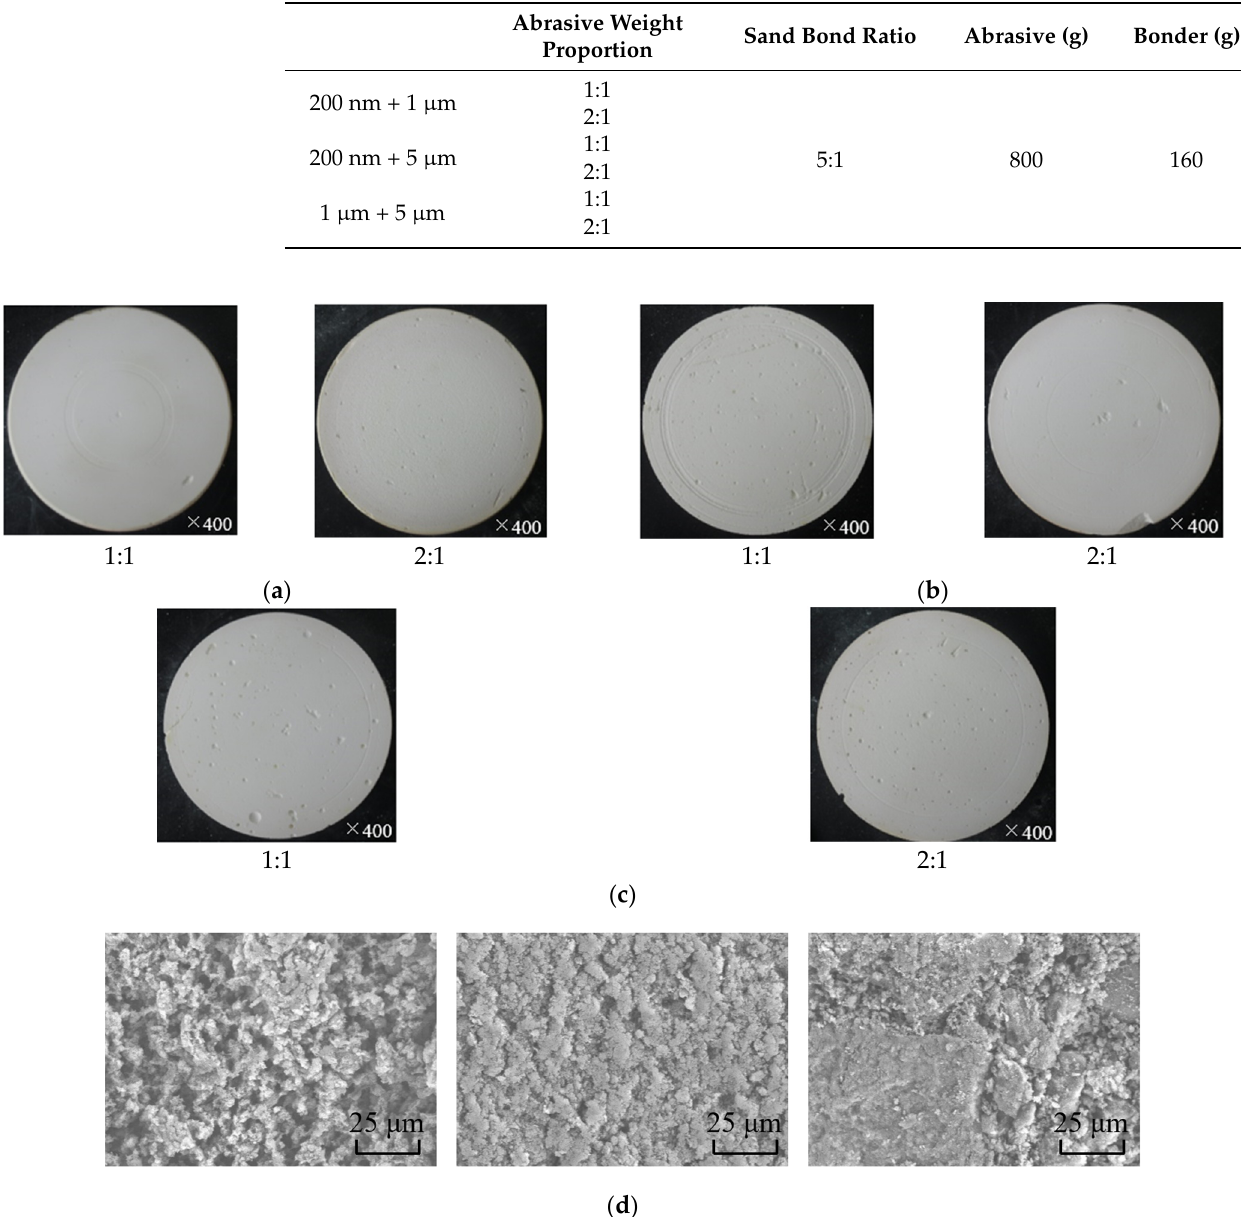
Table 6. Compositions of polishing tool with mixture abrasive particles.